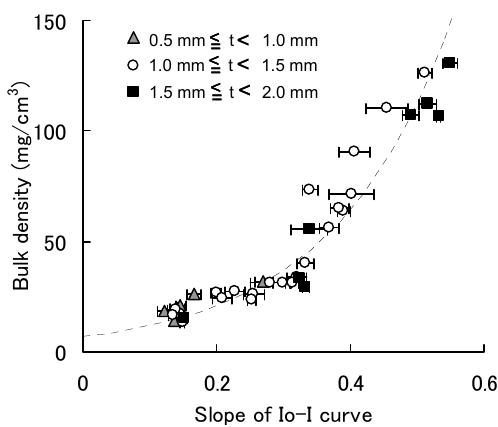
-I curve and the bulk densities of Fig. 8 Relationship between the slopes of I 0 HA-deposited collagen sponge scaffold with a thickness varied in a range from 0.5 to 2.0 mm. The dashed line indicates the calibration curve (y = 6.8579e 5.6053 × , Fig. 3a ） used for the calcification monitoring. Data represent the mean ± SD for four-time